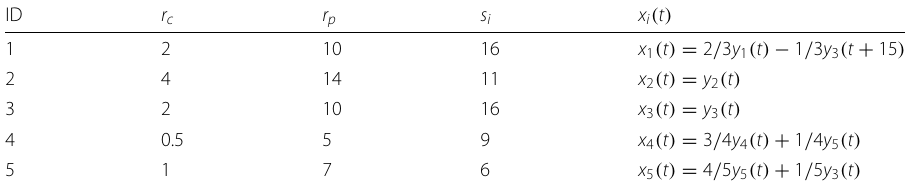
Table 1 Synthetic area generation parameters